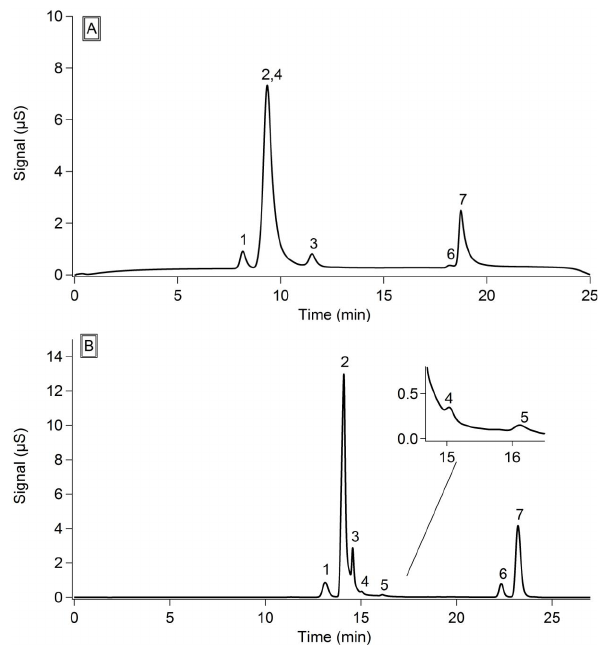
2 Figure 2. Chromatograms of particles collected on the 780 ± 200 nm MOUDI stage at Lambton 3 Shores, ON separated on (A) CS12A and (B) CS17 columns. Compounds are: 1 - sodium, 2 - 4 Fig. 2. Chromatograms of particles collected on the 780 ± 200nm ammonium, 3 - potassium, 4 - dimethylamine, 5 - trimethylamine and diethylamine, 6 - 5 MOUDI stage at Lambton Shores, ON separated on (A) CS12A and magnesium, 7 - calcium. 6 (B) CS17 columns. Compounds are: 1 – sodium, 2 – ammonium, 3 – potassium, 4 – dimethylamine, 5 – trimethylamine and diethy- lamine, 6 – magnesium, 7 –